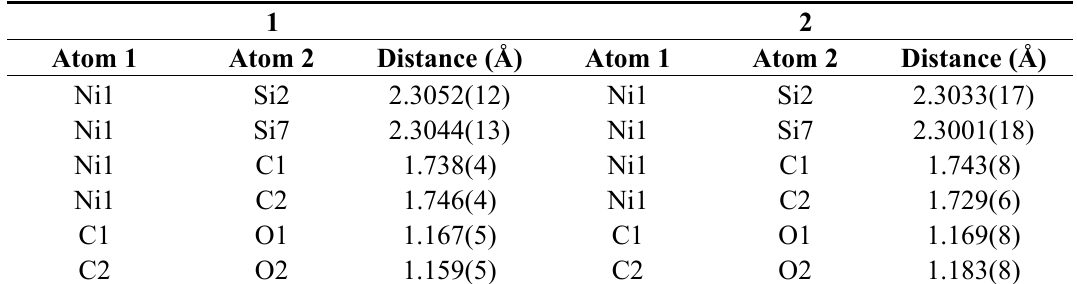
Table 2. Distances within the complex anion [{Ni(CO) 2 } 2 (µ-Si 9 ) 2 ] 8 − in the two known crystal structures 1 and 2 ; atom assignment is given in Figure 2.